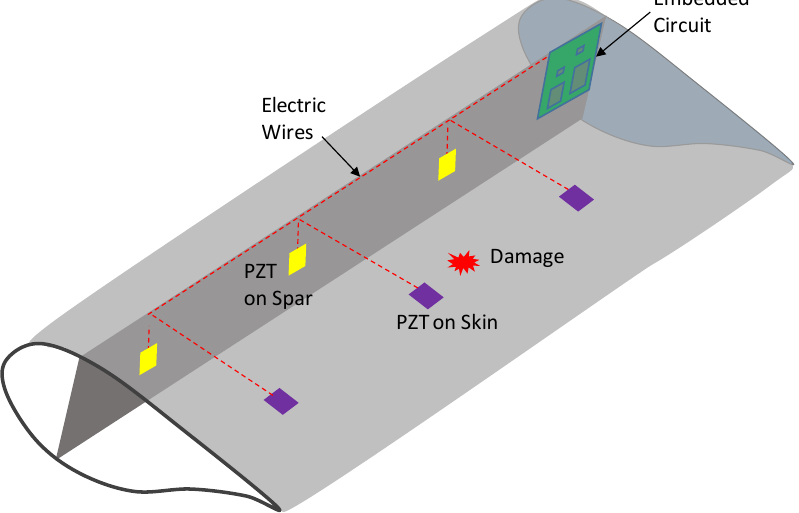
Figure 18. Proposed prototype of an impedance-based smart blade for impedance-based SHM.